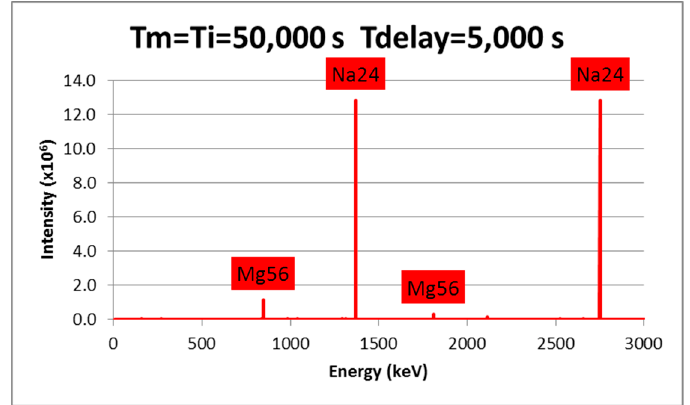
Figure 3. Theoretical spectrum for tm = ti = 50,000 s and td = 5000 s standard